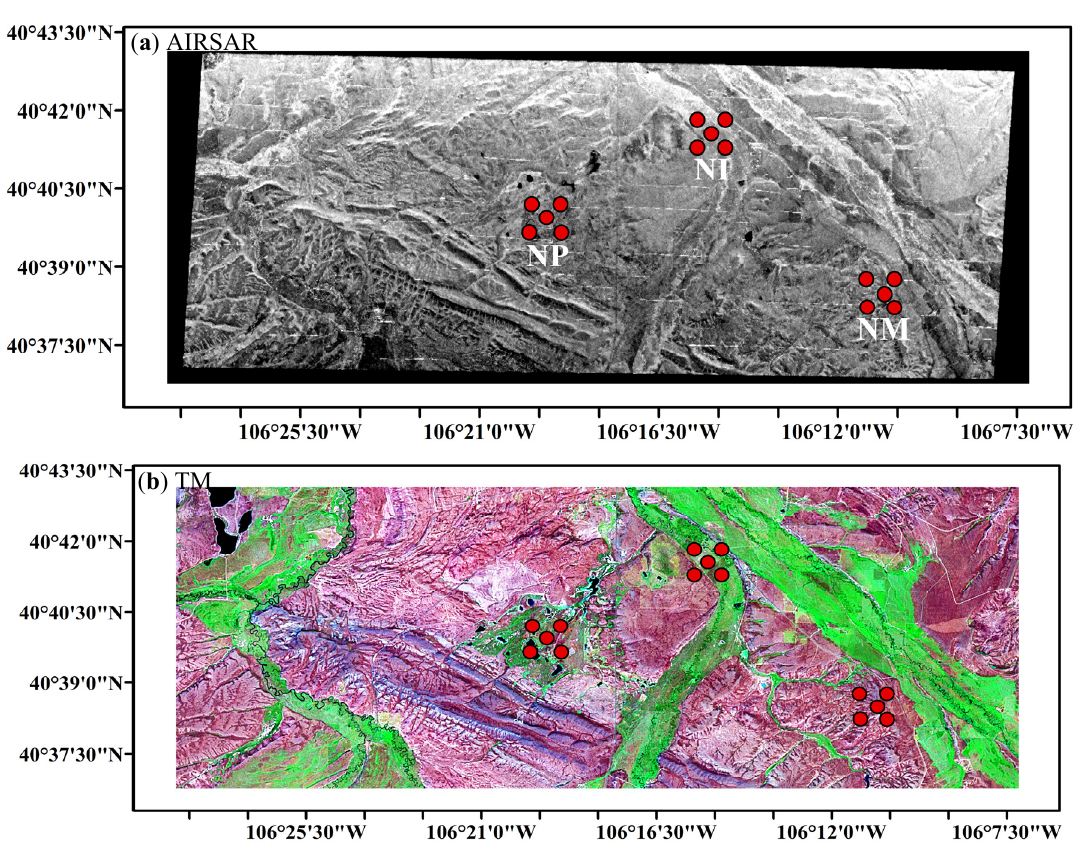
Figure 1. ( a ) HH Polarized L-band AIRSAR Georeferenced image (CM6608) and ( b ) TM band 7, 4, 2 color composite image acquired during September 2001 over the North Park Mesoscale Study Area (MSA); red circles denote locations of the 15 in situ soil moisture and temperature measurement sites. The labels NI, NP and NM represent three Intensive Study Areas (ISAs) inside the North Park MSA, denoted as Illinois River, Potter Creek and Michigan River,